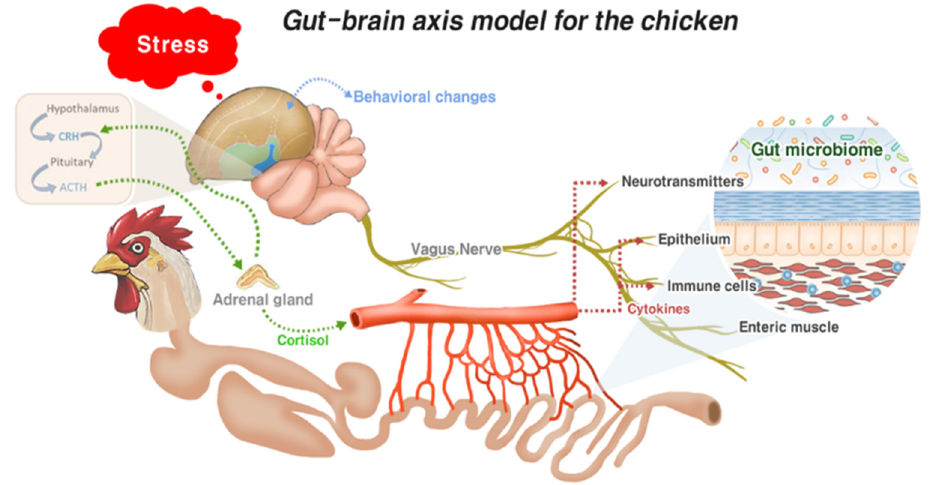
Figure 1. Proposed gut–brain axis model for chickens. The gut–brain axis refers to the bidirectional communication system between the central nervous system and the GI tract. When chickens en- counter enteric stress or inflammation, the intestinal epithelium, enteric muscles, and associated immune cells transmit signals to the brain via the central nervous system (vagus nerve). Further, it induces the leucocytes to release cytokines into circulation from the intestine. Cytokines trigger the activation of the central nervous system. Neurotransmitters produced by chicken gut microbes also induce the central nervous system. All these stimuli from the intestine via the vagus nerve activate the hypothalamic–pituitary–adrenal (HPA) axis and increase the serum corticosterone levels. Corticosterone thereby modulates heterophile migration into the inflammation site of the GI tract to attune inflammation. Activation of the HPA axis leads to sickness behavior in chicken, owing to elevated cortisol secretion.